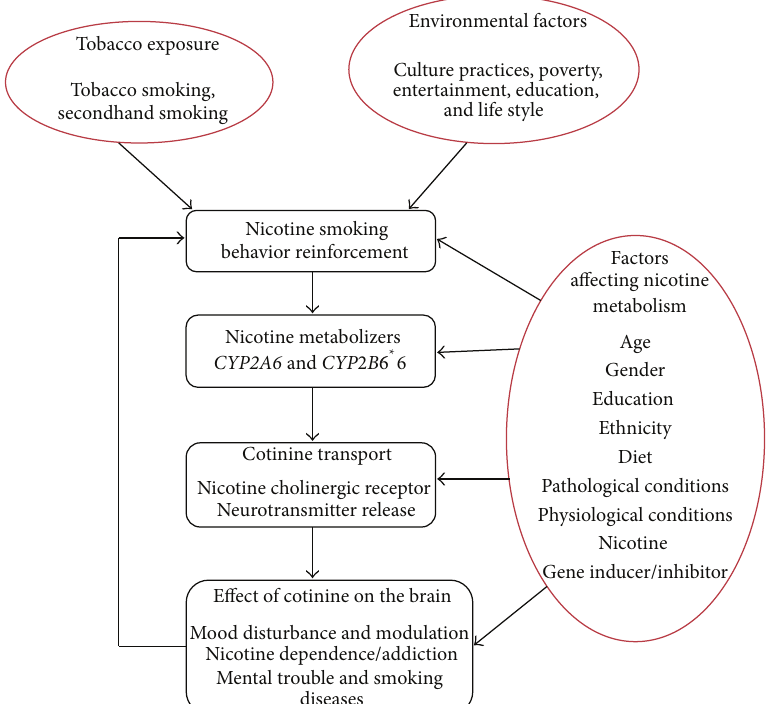
Figure 1: Factors influencing nicotine behavior and metabolism rate. Note. Environmental, cultural, and social factors may influence the development of nicotine intake, but nicotine metabolism is best modulated by CYP2A6 genes which release cotinine into blood to reach brain inducing pleasurable feeling for